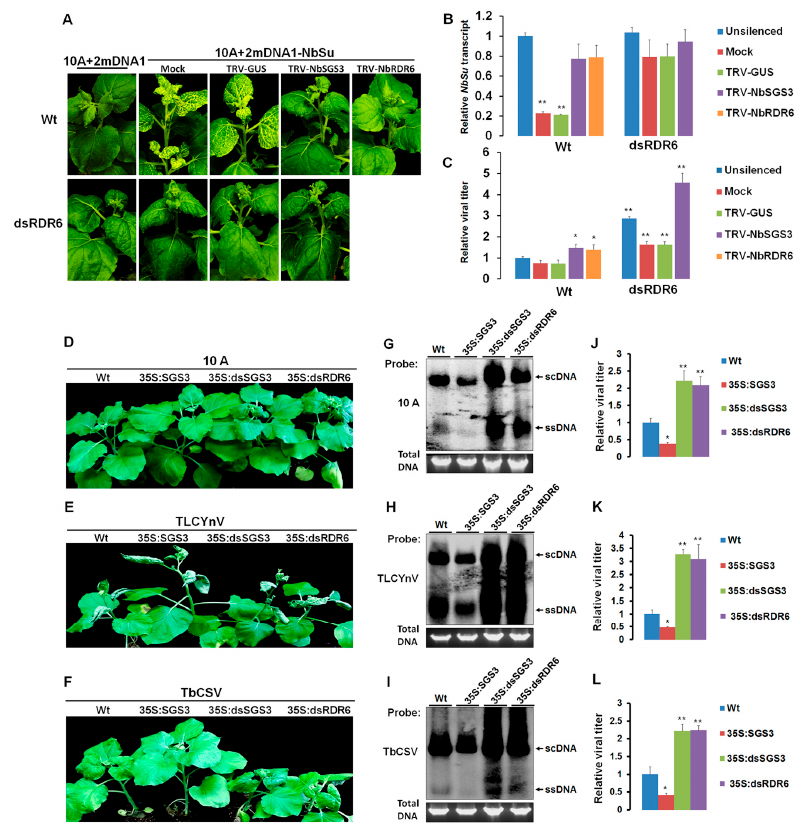
Figure 2. Compromised virus-induced gene silencing (VIGS) efficiency and enhanced susceptibility to geminivirus infection in SGS3 -deficient N. benthamiana . ( A ) Wt or dsRDR6 transgenic N. benthamiana plants were mock inoculated or treated with TRV-GUS, TRV-NbSGS3 or TRV-NbRDR6, followed by infection with the 10A + 2mDNA1-NbSu VIGS vector. The phenotype exhibited by silencing of NbSu was observed at 30 dpi. Wt or dsRDR6 plants infected with an empty VIGS vector (10A + 2mDNA1) were used as non silenced controls; ( B ) RT-qPCR analysis of NbSu silenced plants. The relative levels of NbSu mRNA isolated from plants shown in ( A ) were normalized to mRNA of NbGAPDH that served as an internal standard. NbSu mRNA detected in Wt or dsRDR6 transgenic N. benthamiana plants infected by the empty VIGS vector (10A + 2mDNA1) represented levels present in non silenced plants. The relative level of NbSu mRNA in non silenced Wt plants is arbitrarily set as 1. Values represent the mean ± standard deviation (SD) from three independent experiments ( n = 9). Student’s t test was performed to compare differences between unsilenced Wt and NbSu silencing plants and double asterisks indicate a highly significant difference ( p < 0.01); ( C ) relative TYLCCNV (10A) DNA levels in plants shown in ( A ) which were normalized to 25S rRNA that served as an internal plant genomic DNA control. The relative level of 10A DNA in unsilenced Wt plants is arbitrarily set as 1. Values represent the mean ± standard deviation (SD) from three independent experiments ( n = 9). Student’s t test was performed to compare differences between unsilenced Wt and NbSu silencing plants and double asterisks indicate a highly significant difference ( p < 0.01); ( D – F ) symptoms induced by TYLCCNV(10A), TLCYnV or TbCSV when inoculated to Wt N. benthamiana plants or plants transgenic for 35S:SGS3, 35S:dsSGS3 or 35S:dsRDR6 at 20 dpi. Southern blot analyses ( G – I ) and qPCR ( J – L ) of geminivirus DNA accumulation in systemic leaves of the infected plants shown in ( D – F ). The relative level of viral DNA in infected Wt plants is arbitrarily set as 1. 25S rRNA levels served as an internal plant genomic DNA control. Values represent the mean ± standard deviation (SD) from three independent experiments ( n = 9). Student’s t test was performed to compare differences between Wt and 35S:SGS3, 35S:dsSGS3 or 35S:dsRDR6 transgenic N. benthamiana plants, a single asterisk indicates a significant difference ( p < 0.05) and double asterisks indicate a highly significant difference ( p <